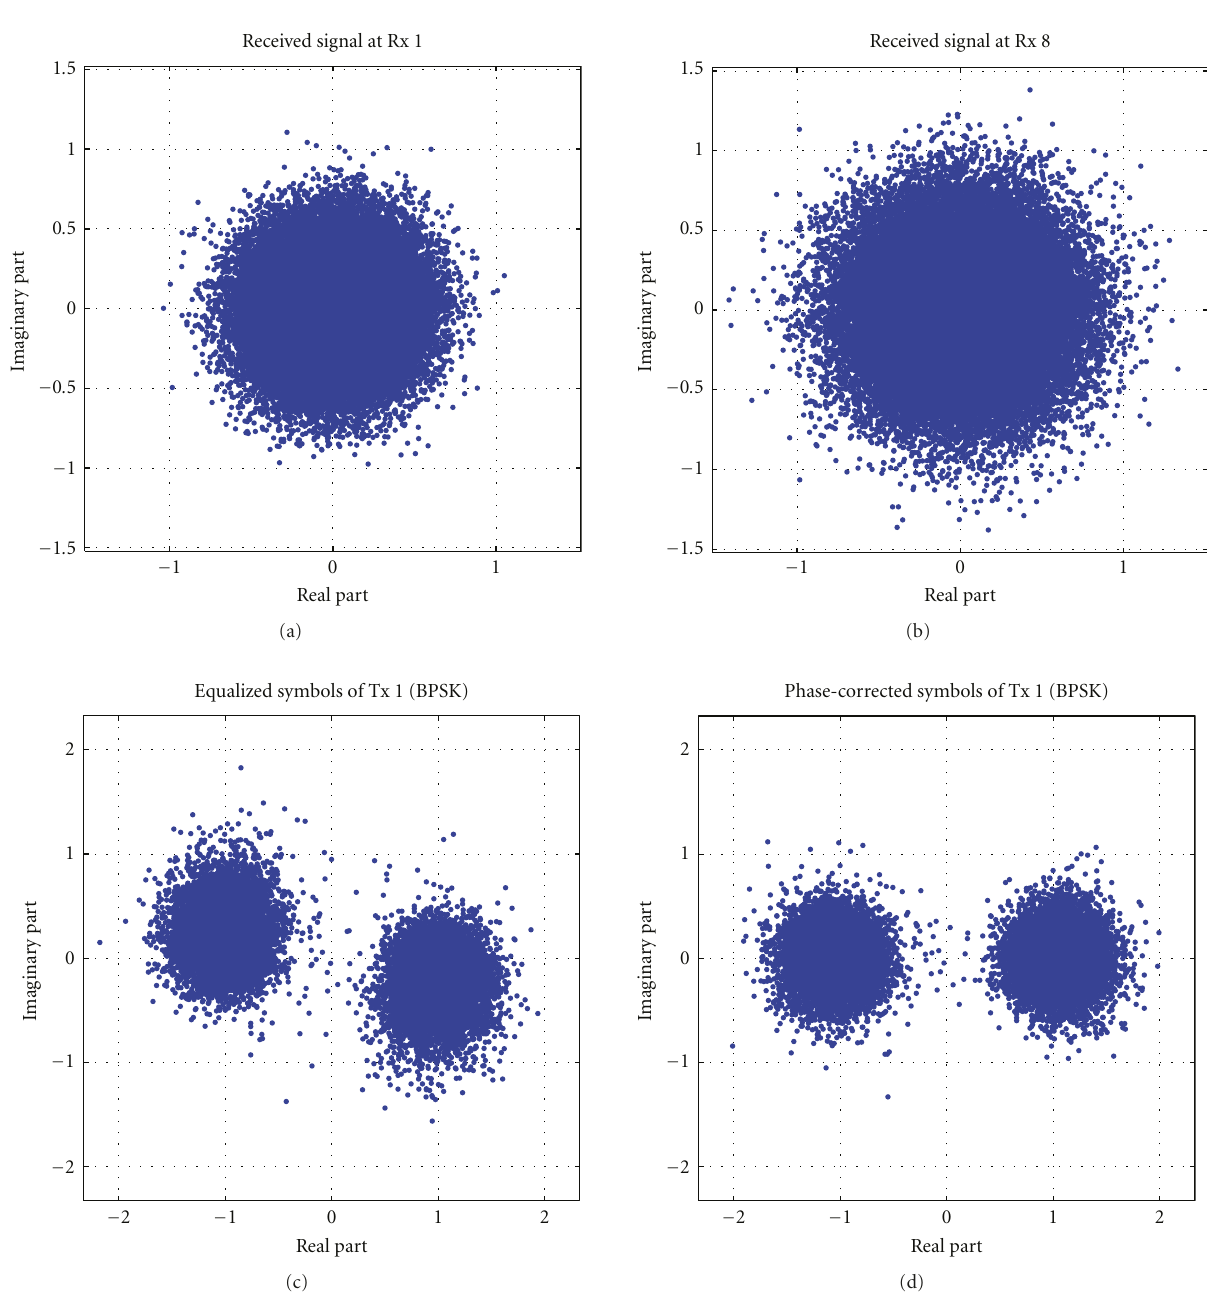
Figure 9: Received baseband signal, equalized and phase-corrected BPSK